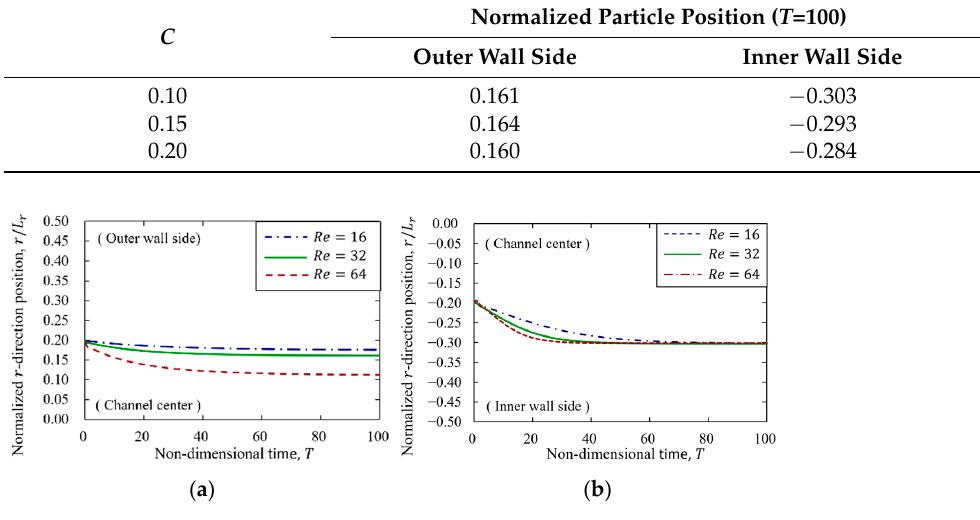
Figure 12. Particle migration for varying Reynolds number 𝑅𝑒 with 𝐶 = 0.10 . ( a ) Particle migration on outer wall side. ( b ) Particle migration on inner wall side. Table 7. Value of particle position at 𝑇 = 100 for varying Reynolds number 𝑅𝑒 = 16 ~64 with 𝐶 = 0.10 .